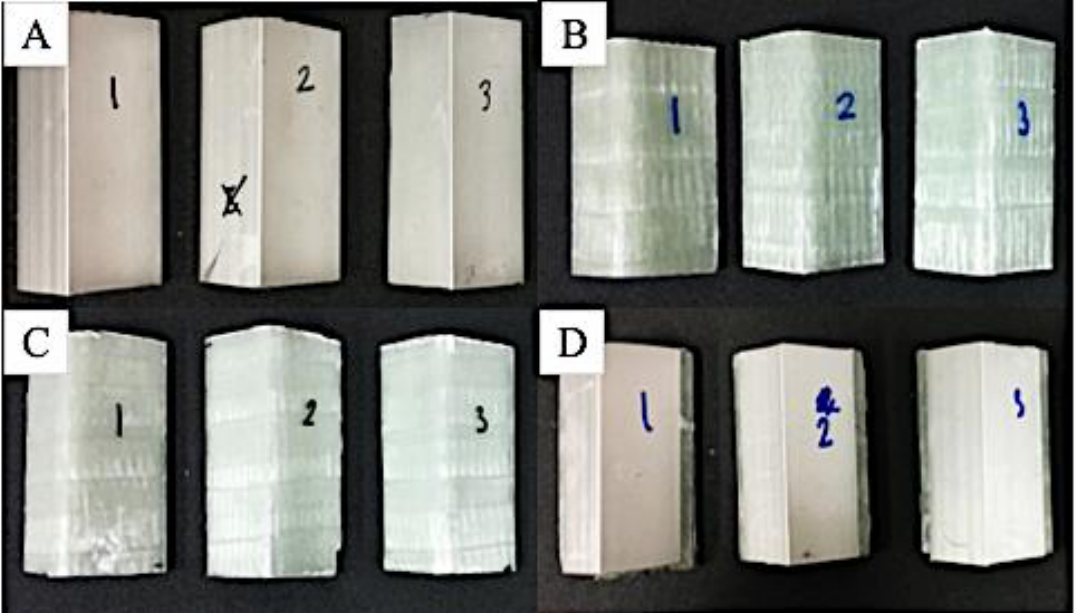
Figure 6. Axial compression test specimens. ( A ) Aluminium L-Profile; ( B ) GFRP Profile; ( C ) Hybrid laminates with GFRP attached on the outer surface of L-Profile; ( D ) Hybrid laminates with GFRP attached on the inner surface of